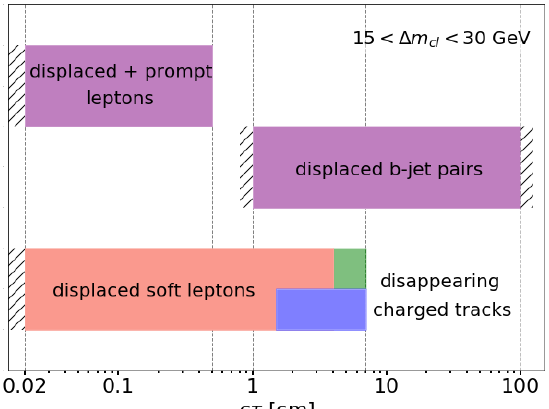
Figure 7 . Sensitivity regions for displaced signatures at the LHC. Shown are the ranges of nominal decay lengths of (cid:31) + (salmon) or (cid:31) h (purple) that can be tested by ATLAS and CMS. Green and blue parameter regions have already been excluded by searches for disappearing charged